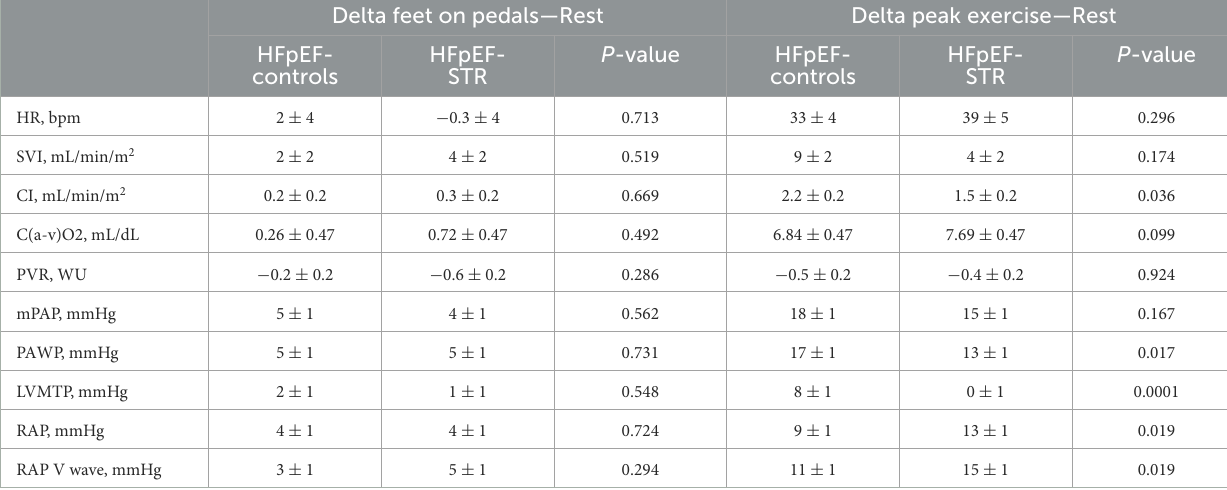
TABLE 3 Changes in hemodynamics between rest and feet on the pedals, and between rest and at peak exercise in the study cohort.